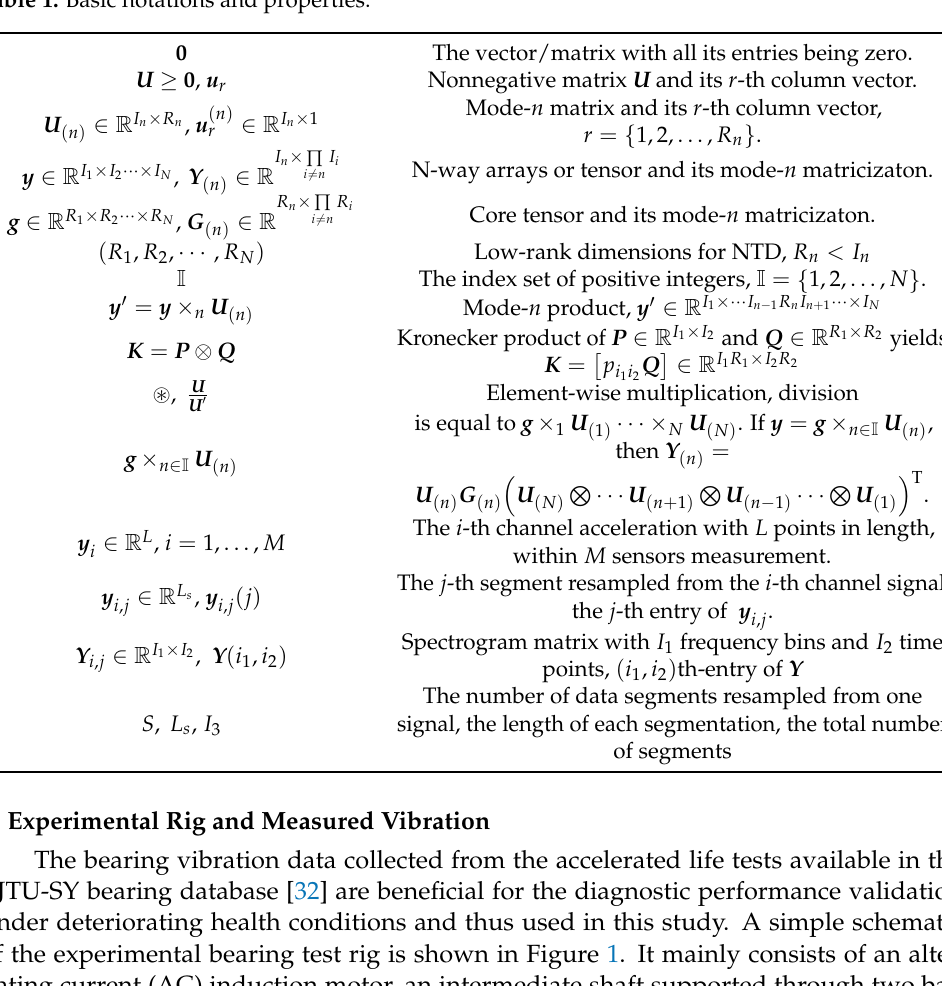
Table 1. Basic notations and properties.